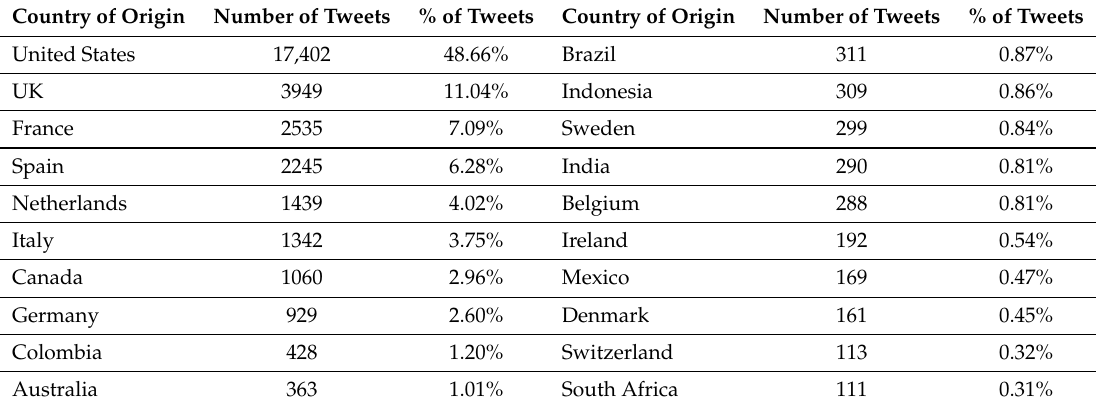
Table 4. Top 20 Countries for Volume of Tweets.